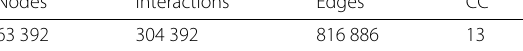
Table 1 Base statistics of the analyzed Facebook graphs Nodes